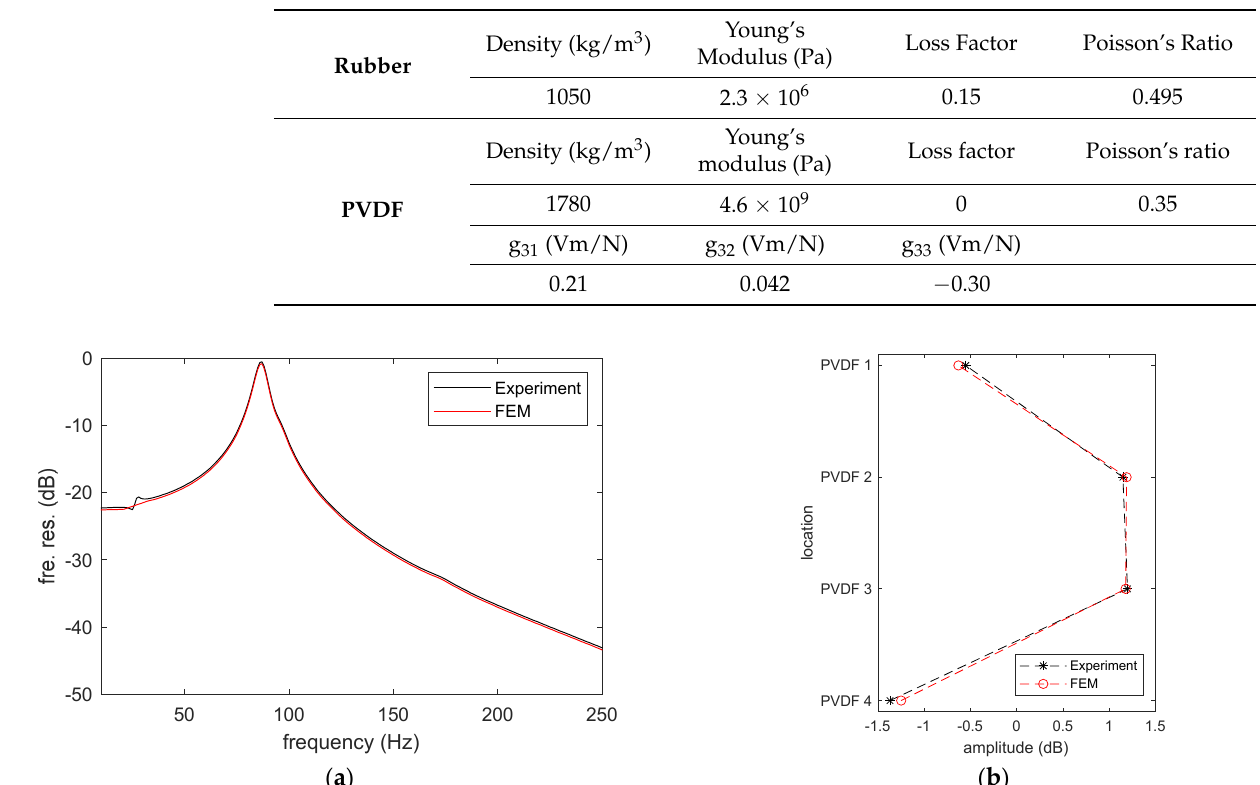
Table 1. Parameters used in FE model.